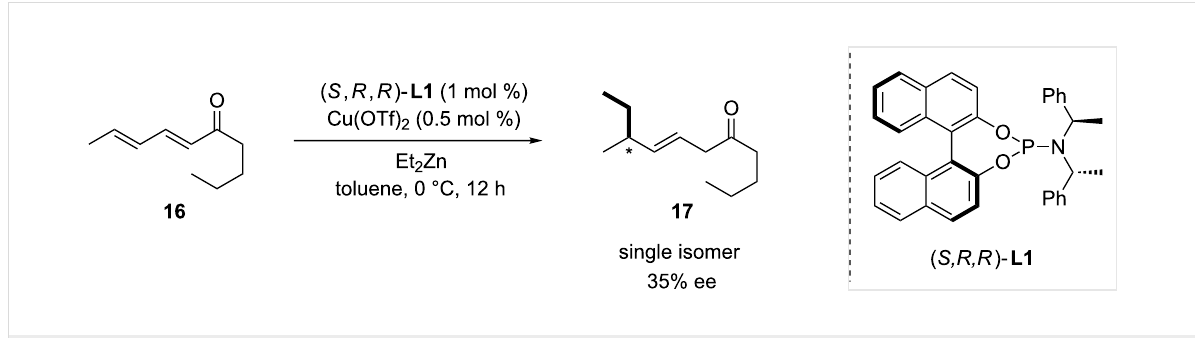
Scheme 1: First example of enantioselective copper-catalyzed ACA on an extended Michael